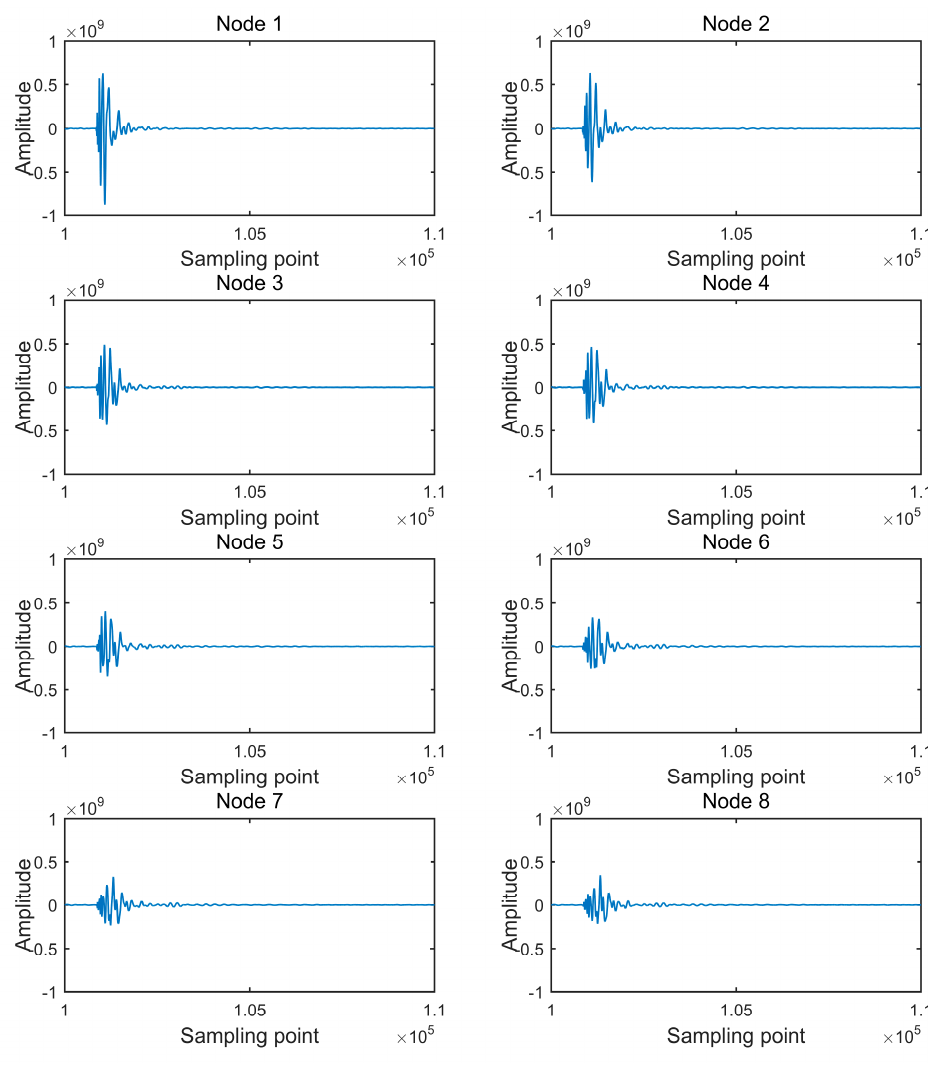
Figure 10. Detailed direct waves of received data.